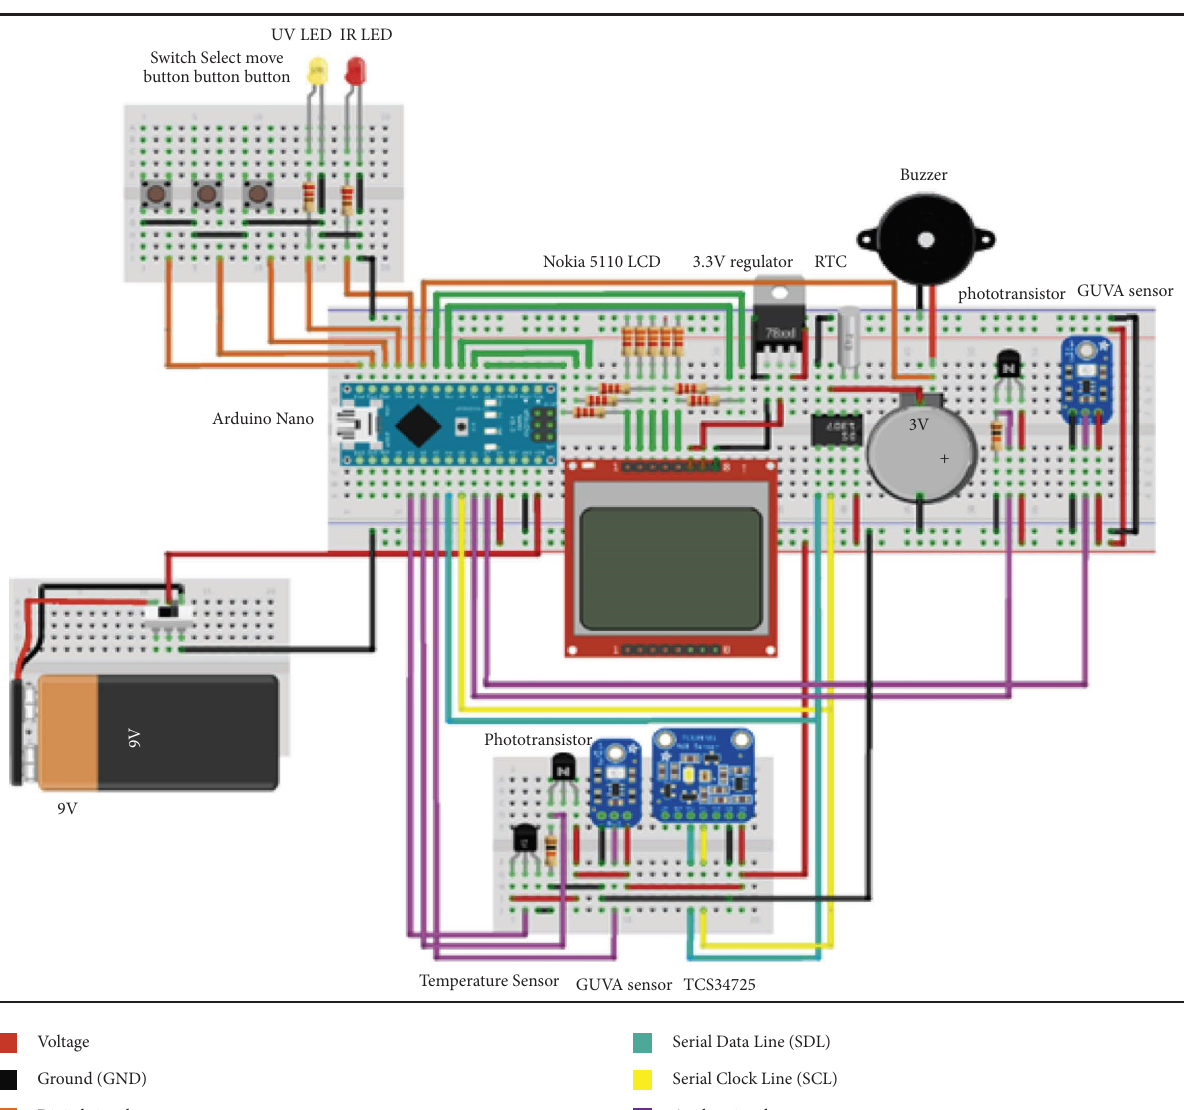
Figure 3: Solar band circuit diagram. Te wire’s color key is shown on the right side of the